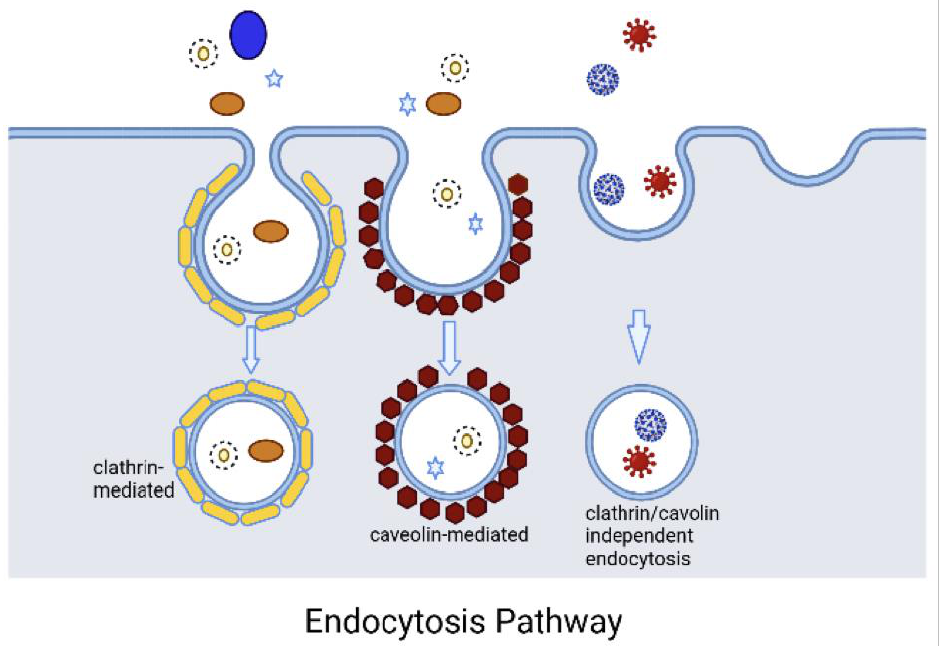
Figure 3. Types of Endocytosis pathway to overcoming GI barriers .